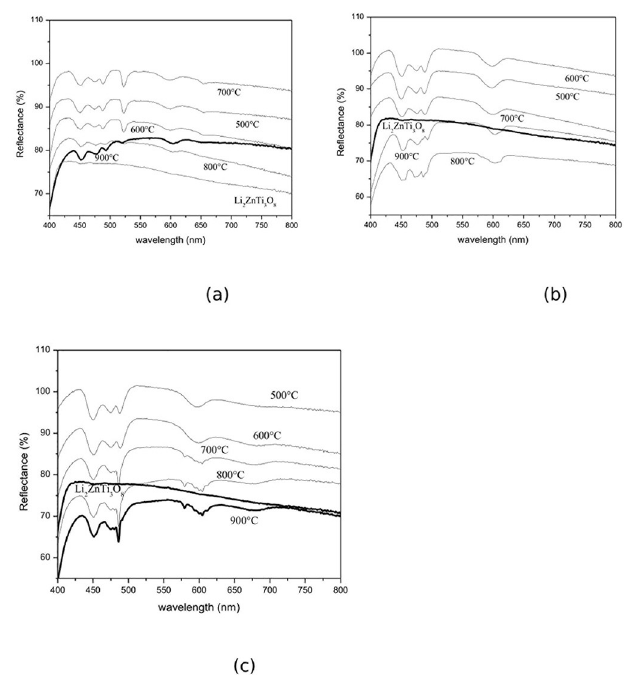
ZnTi O spinel, calcined at the 500-900°C temperature range, and doped with Pr 3+ (a) 0.01mol%, 2 3 8